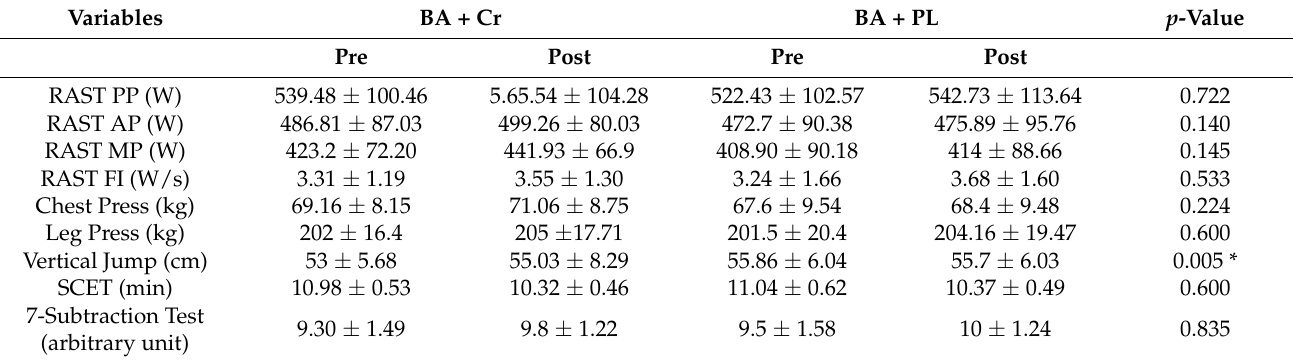
Table 2. Changes in physical and cognitive performance before and after 4 weeks of